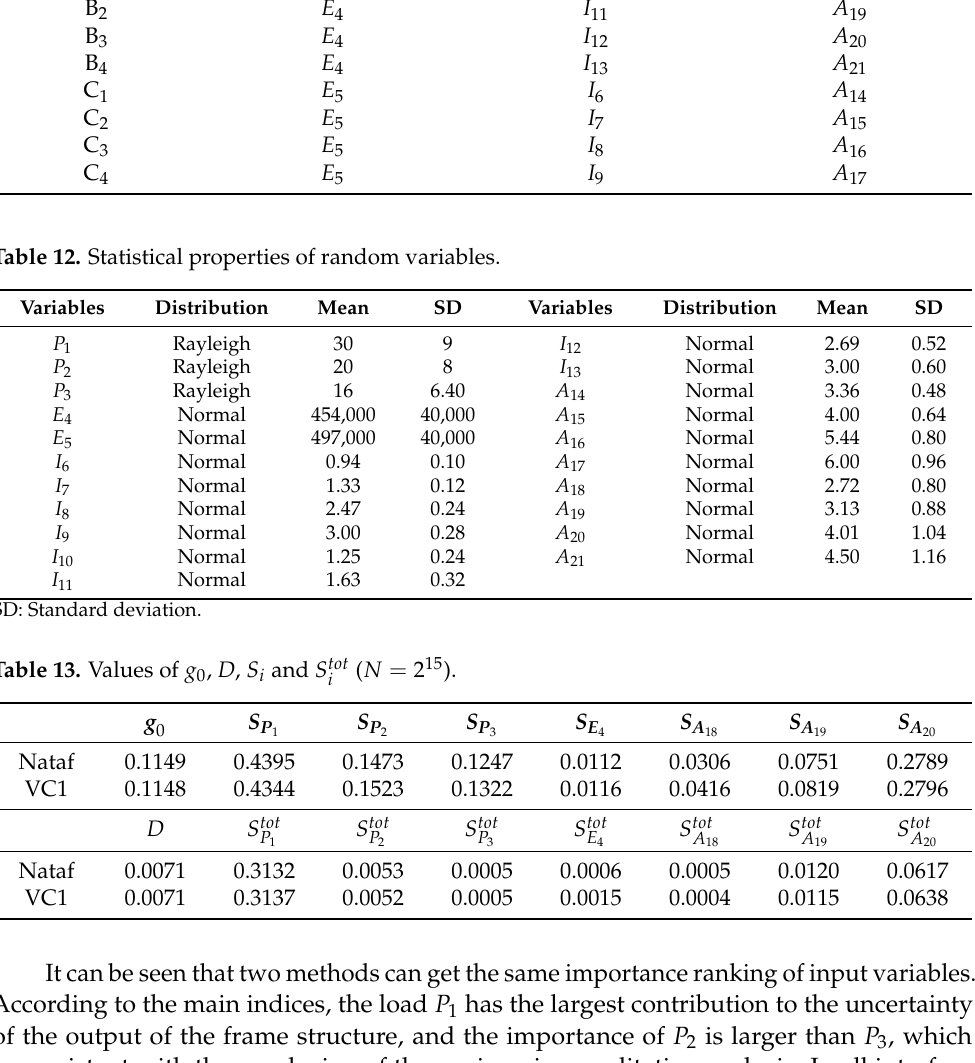
Table 11. Properties of the frame structures. Element